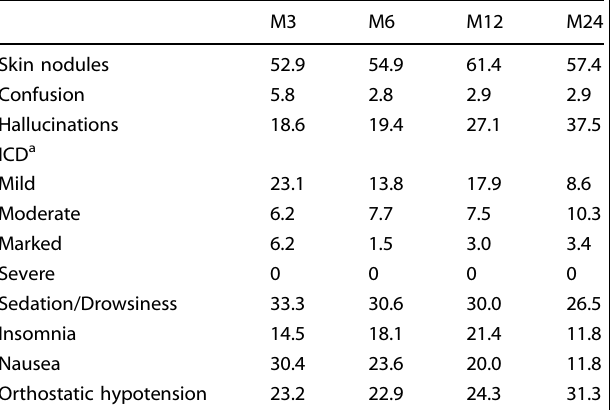
Table 5. Prevalence of adverse effects in